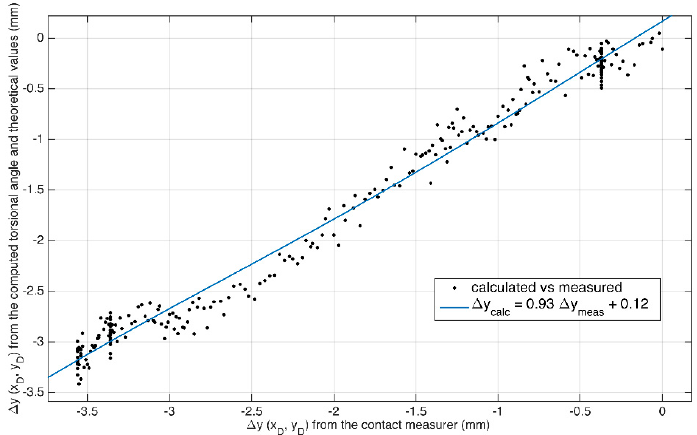
Figure 12. Vertical displacement computed from Equation (10) with theoretical values for ∆ y B , r D , y D , and γ D , and the torsional angle obtained with the proposed method versus the vertical displacement measured with the contact measurer at the point D (black dots). The blue line represents the linear least-square fitting.